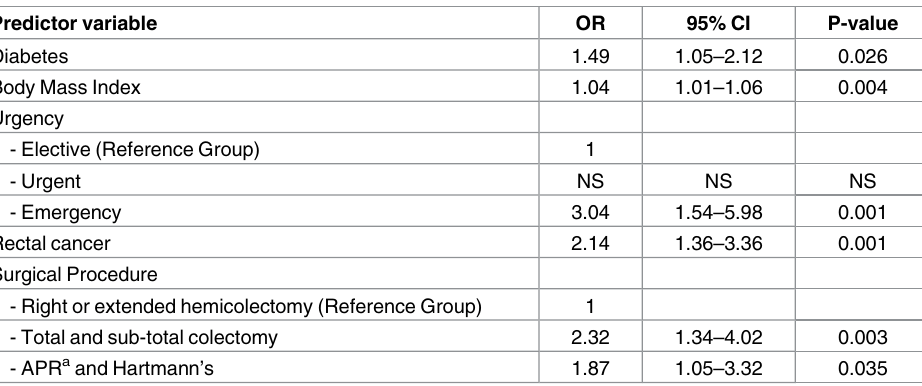
Table 7. Predictive factors of surgical